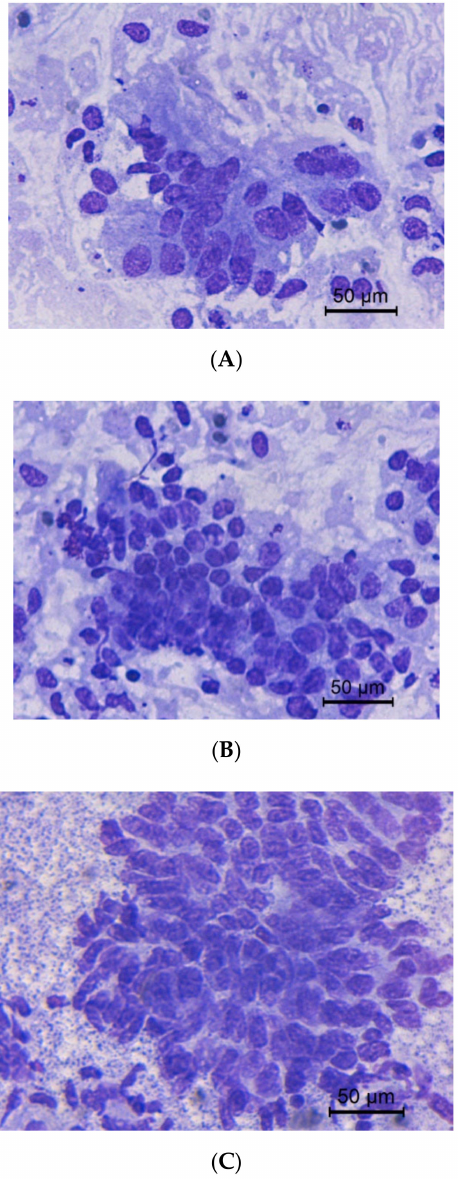
Figure 2. Scores of cellularity in jennie’s cytobrush Examples of low ( A ), moderate ( B ), and high ( C ). The predominant cells are endometrial epithelial cells, seen individually and in clusters. Modified Wright’s stain, 400 ×